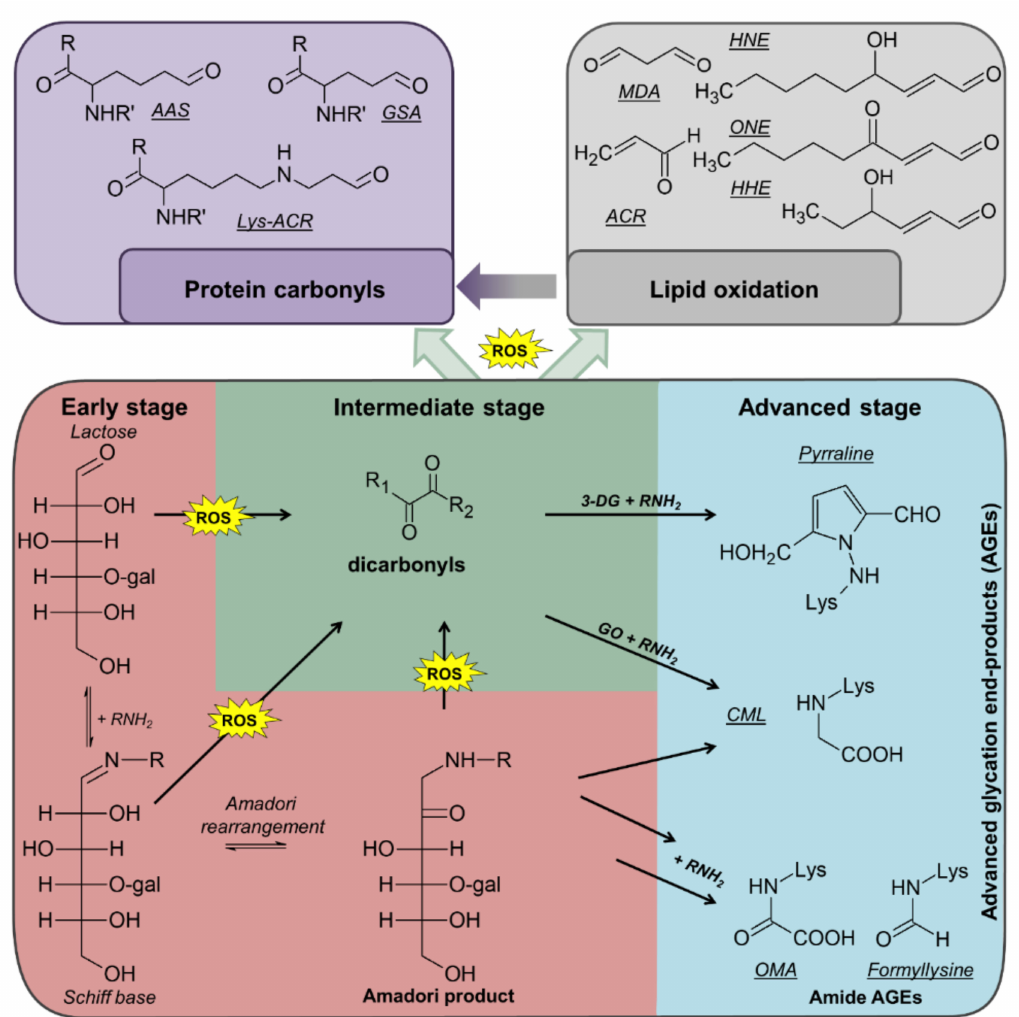
Figure 1. Overview of reactions that can occur during thermal processing of milk. ROS, reactive oxygen species; gal, galactose; OMA, oxalic acid monolysinylamide; CML, carboxymethyllysine; GO, glyoxal; 3 DG, 3-deoxyglucosone; ACR acrolein; MDA, malondialdehyde; HHE, 4-hydroxy-2-hexenal; HNE, for 4-hydroxy-2-nonenal; ONE, 4-oxo-2-nonenal; AAS, 2 amino-adipic-semialdehyde; GSA,